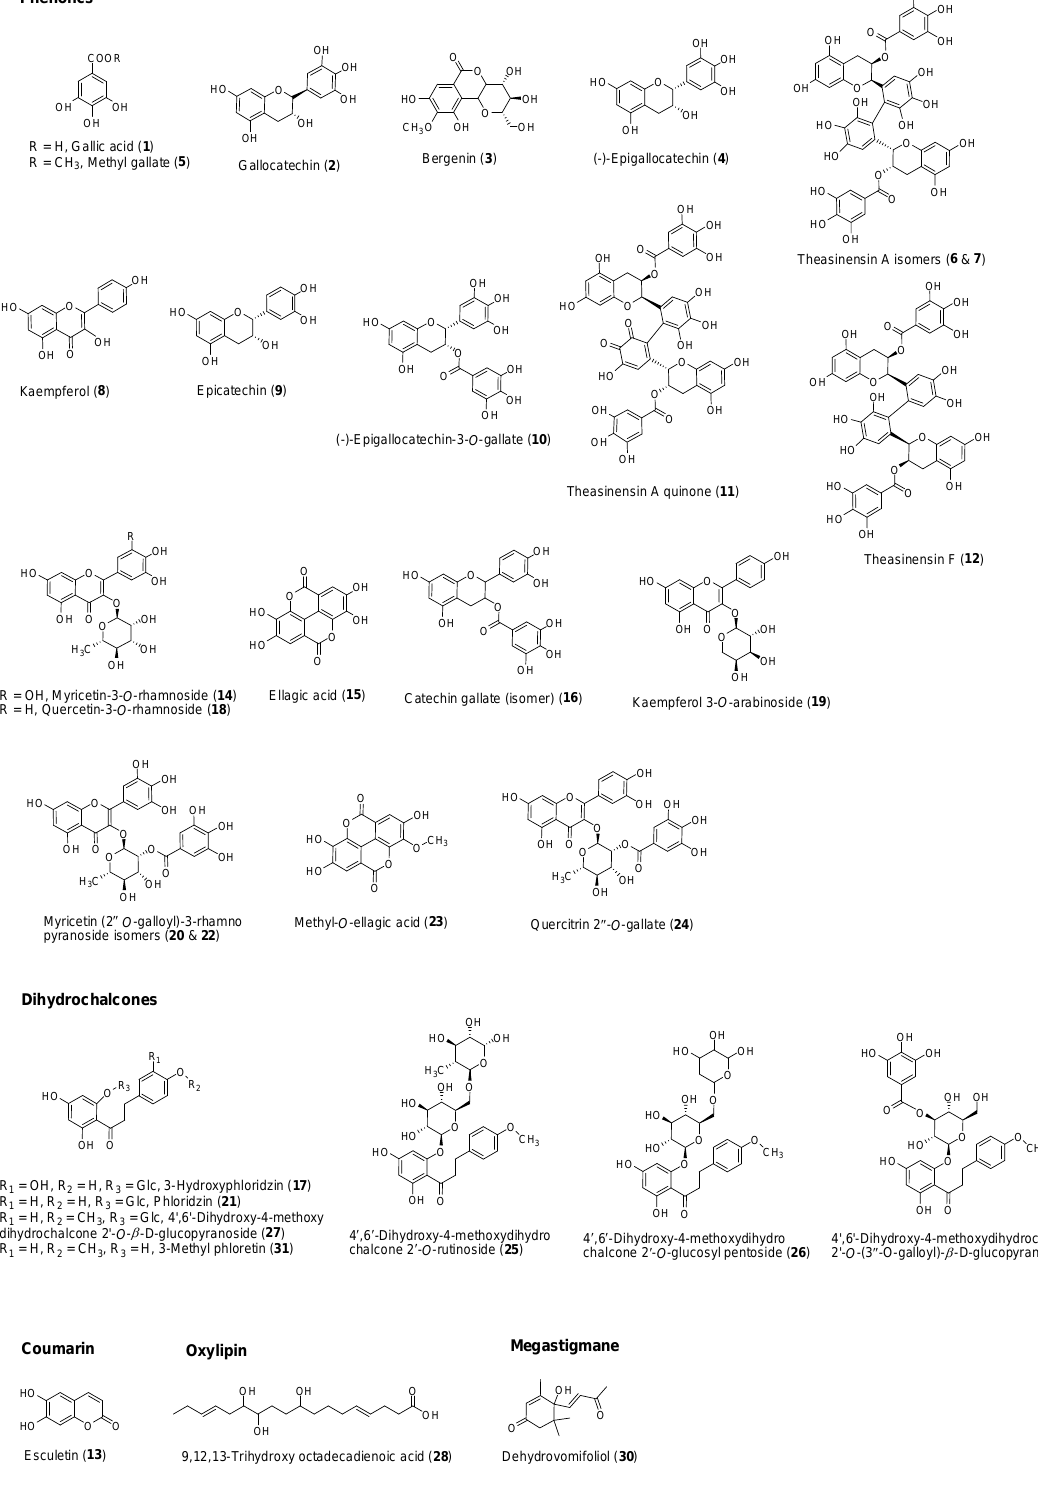
Figure 2. Structures of compounds identified in L. indica according to their chemical classes. In LC-MS spectra, peaks 25 , 26 and 29 eluted at retention times (RT) 51.4, 52.1 and 55.0 min, and showed precursor ions [M − H] − at m / z 595.2031, 581.1889 and 601.1595, respectively. Peaks 25 ( m / z 595) and 26 ( m / z 581) showed a mass difference of 146 Da (rhamnose) and 132 Da (arabinose/xylose) respectively compared to the isolated dihydrochalcone 27 ( m / z